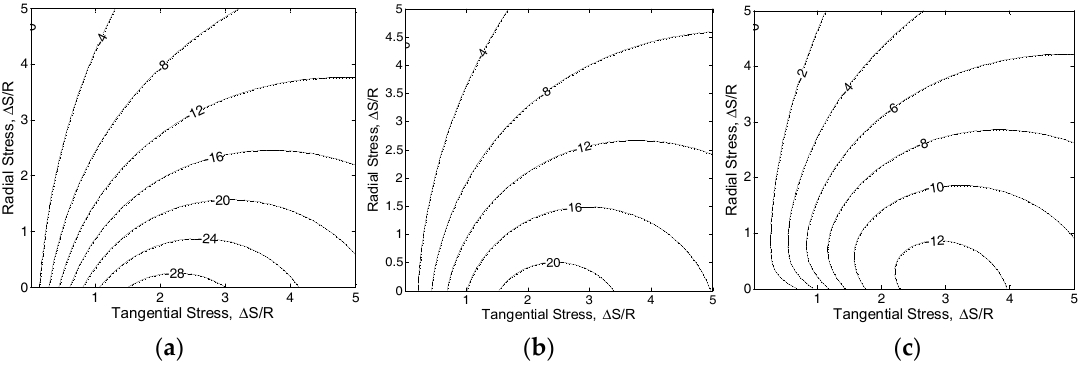
Figure 5. Validation of the linear α -method: ( a ) central difference, α = 1/2; ( b ) skewed difference, α = 2/3; and ( c ) backward Euler integration, α =